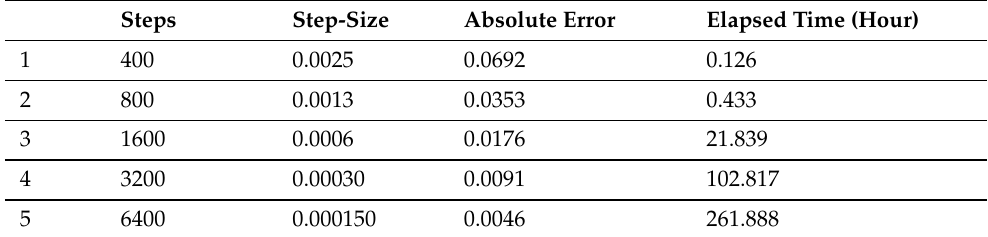
Table 1. Implementation of the Milstein scheme.